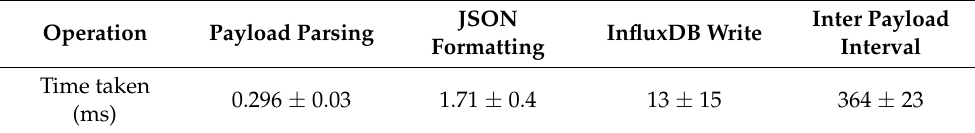
Table 5. Timing involved with different operations within the FogNode client application.